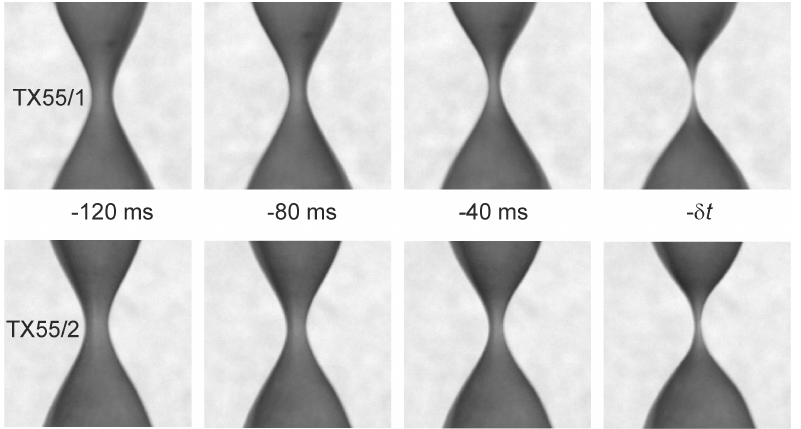
Figure 10. The pinch-off of ST02890 during the transition from smectic A into the nematic phase at an elongation of α = 4. When the material melted, the stability provided by the yield stress was lost: The column started thinning in the center and finally pinched off (image sizes were 5 mm × 5 mm);